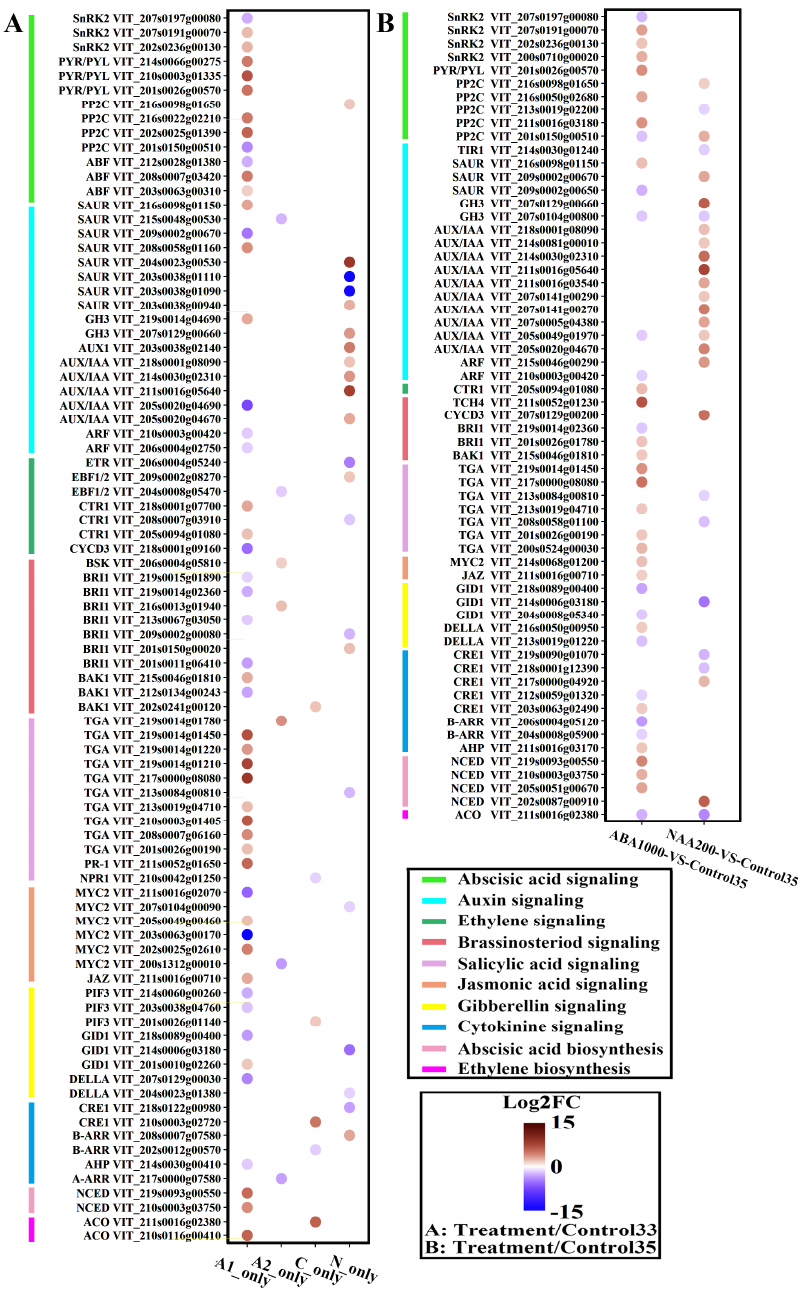
Figure 5. Expression of the genes responsible for hormone biosynthesis and signaling. ( A ): Di ff erentially expressed genes (DEGs) only exist in sets of A1, A2, C, and N. ( B ): DEGs in sets of ABA1000 vs. Control35 and NAA200 vs. Control35. The colors of the circles represent the intensity of the expression fold changes (log2). A1_only: DEGs specifically present in the comparison of ABA1000 vs. Control33; A2_only: DEGs specifically present in the comparison of ABA500 vs. Control33; C_only: DEGs specifically present in the comparison of Control35 vs. Control33; N_only: DEGs specifically present in the comparison of NAA200 vs.